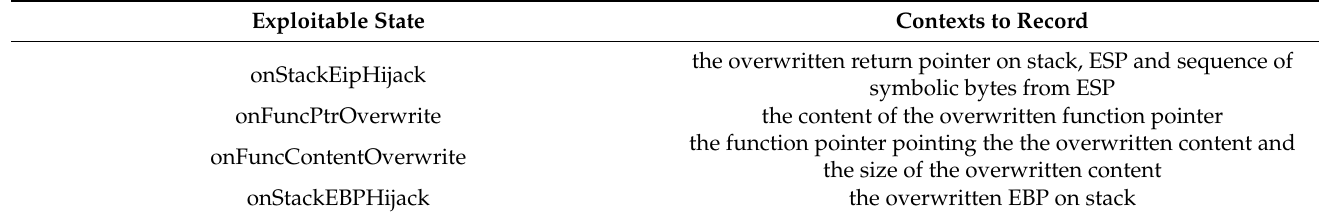
Table 1. Specifications on Exploitable States.